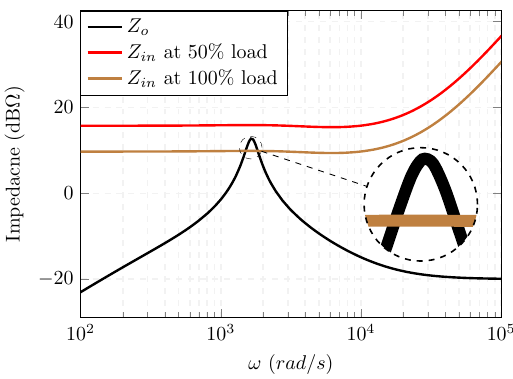
Figure 7. Impedance interaction for the experimental system, for the original controller, with two different loading conditions.